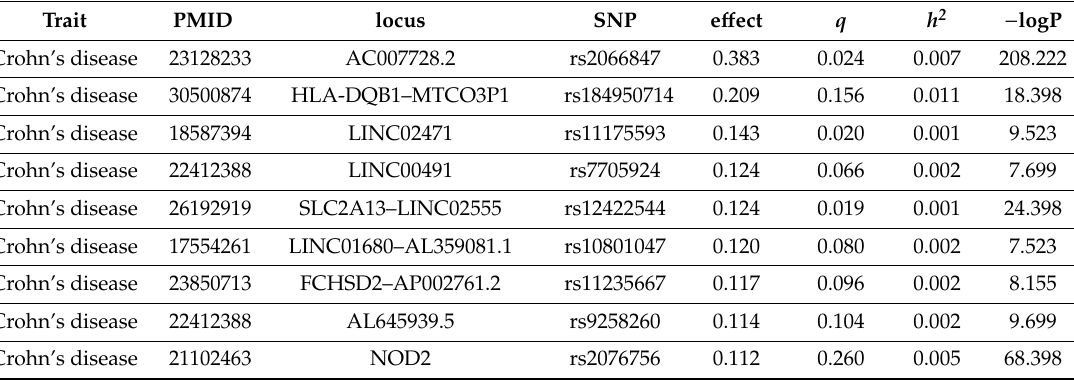
Figure 2. Screenshot of GWEHS (Genome-Wide E ff ect size and Heritability Screener) showing the locus contributions to heritability for Digestive disease (i.e., Crohn’s disease and Inflammatory bowel disease), using the default parameters, except for the percentage of low and high-e ff ect size loci, which was set to 50% and 5%, respectively. Table 1. Illustration of the first rows in the table generated by GWEHS (Genome-Wide E ff ect size and Heritability Screener), showing example data for Digestive disease (i.e., Crohn’s disease and Inflammatory bowel disease), using the default